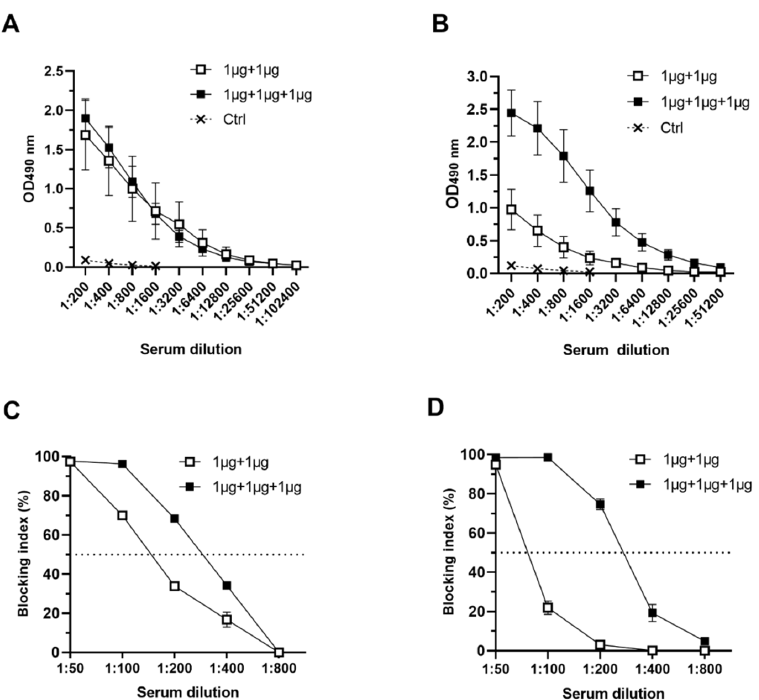
Figure 6. Serum norovirus (NoV)-specific antibody responses induced by equal doses of NoV VLPs and rotavirus (RV) VP6. Groups of mice immunized either with 1 µg of NoV GI.4 and GII.4-2006a VLPs or combined with 1 µg VP6 were individually tested for ( A ) GI.4- and ( B ) GII.4-2006a-specific serum IgG with two-fold dilutions starting at 1:200. Control (Ctrl) mice received carrier only. Pooled serum of both groups was tested for blocking of VLP binding using pig gastric mucin (PGM)–based assay. Shown are blocking titration curves of ( C ) GI.4 and ( D ) GII.4-2006a VLP binding. Horizontal dashed line represents 50% blocking.